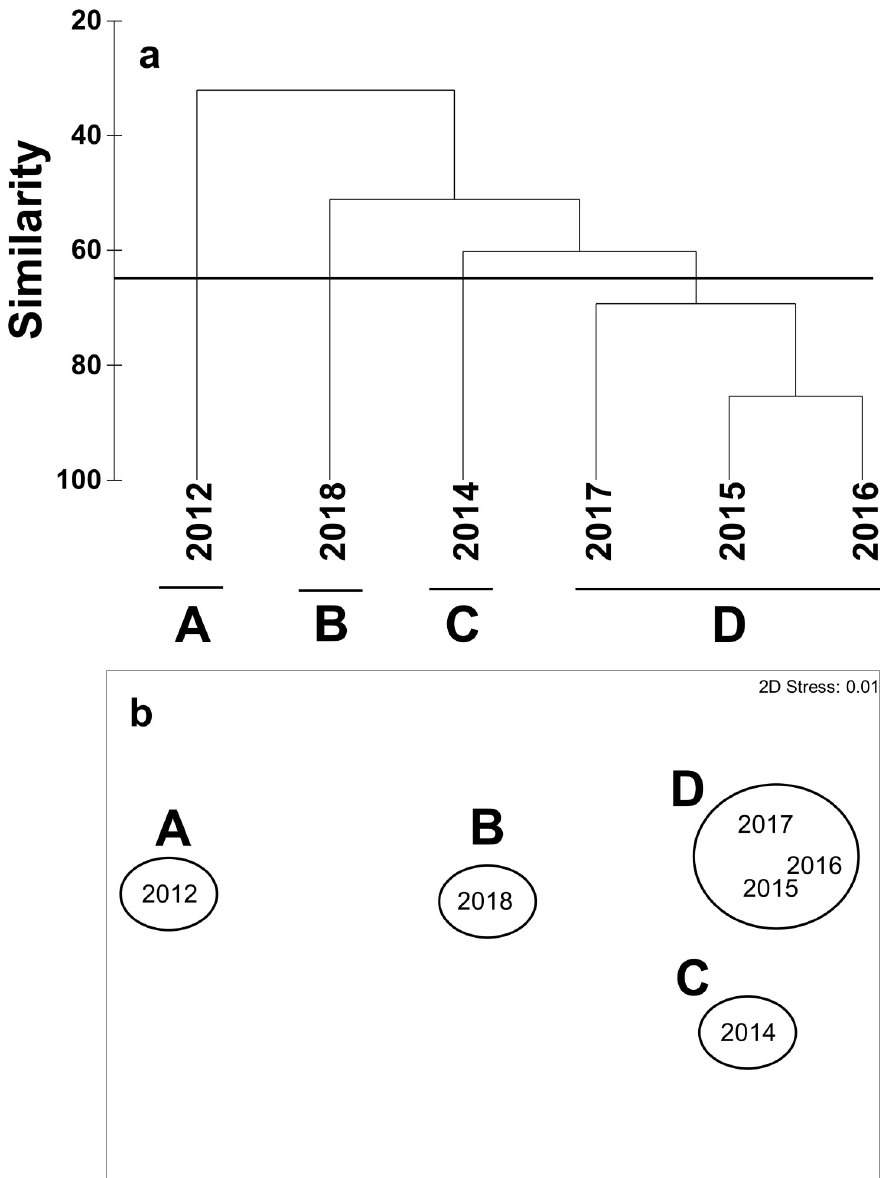
Fig 5. Cluster analysis and nMDS ordination of marine organism coverage. Dendrogram of the hierarchical clustering of marine benthic assemblages (similarity threshold, 65%) based on Bray-Curtis similarities (a) and nMDS plot